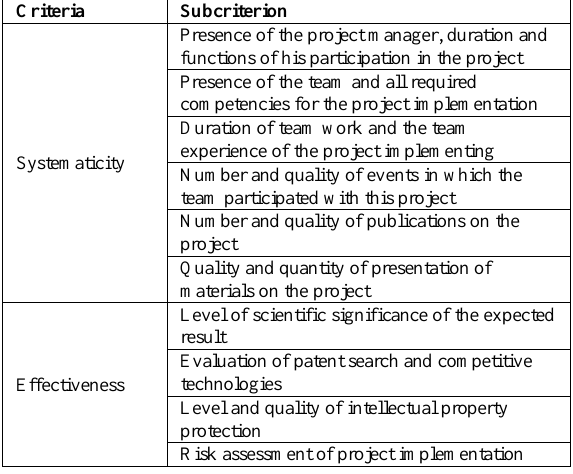
Table 2. Comparative analysis of the models